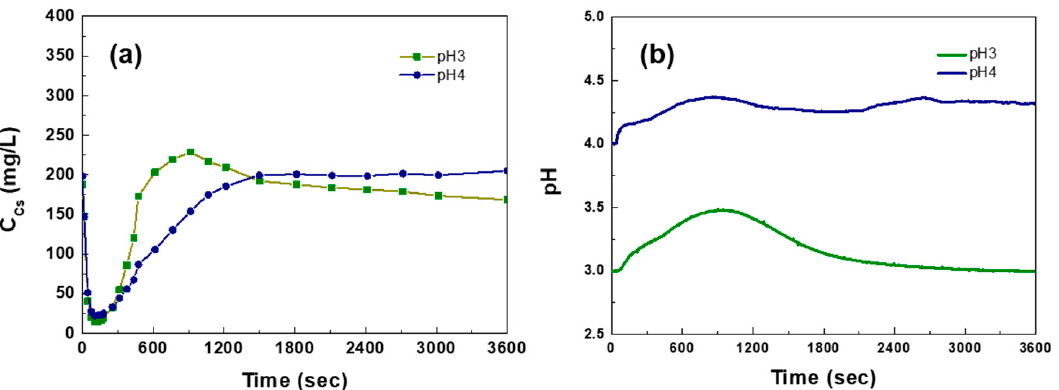
8 of 11 Figure 7. Maximum adsorption capacity of Cs + ions as a function of flow rate and influent concen- tration. Adsorption was conducted until the cell potential reached 1.2 V (Experimental conditions: Influent of pH 3 was fed for 60 min adsorption). The radioactive wastewater containing Cs + generated in nuclear facilities is stored in a highly acidic solution, and the pH value is an important indicator. We measured the effect of pH to further investigate the electrosorption performance for the AC-CPL. Figure 8a shows the concentration of Cs + in the effluent water during the electrosorption process. The concentration of Cs + in the effluent decreased rapidly at the initial stage and gradually increased to the initial concentration. In particular, the amount of adsorbed Cs + decreased after the electrode reached saturation at pH 3, which was presumably due to the co-ions release from the EDL near the pores and neutral salt discharge from the electrode [12]. We monitored the pH variation of the influent solution during the electrosorption process, and the results are shown in Figure 8b. In contrast to the concentration curves of Cs + ions in the effluent, the water pH variation showed the opposite trend, indicating that H + ions were competitively electrosorbed at the electrode surface. This result was definitively ob- served at pH 2 (Figure S1). It shows that the concentration of the effluent reached 31.92 mg L − 1 in the first 45 s and increased rapidly to the initial influent concentration. The max- imum adsorption capacity was 0.75 mg g − 1 , and it can be seen that the adsorption of H +